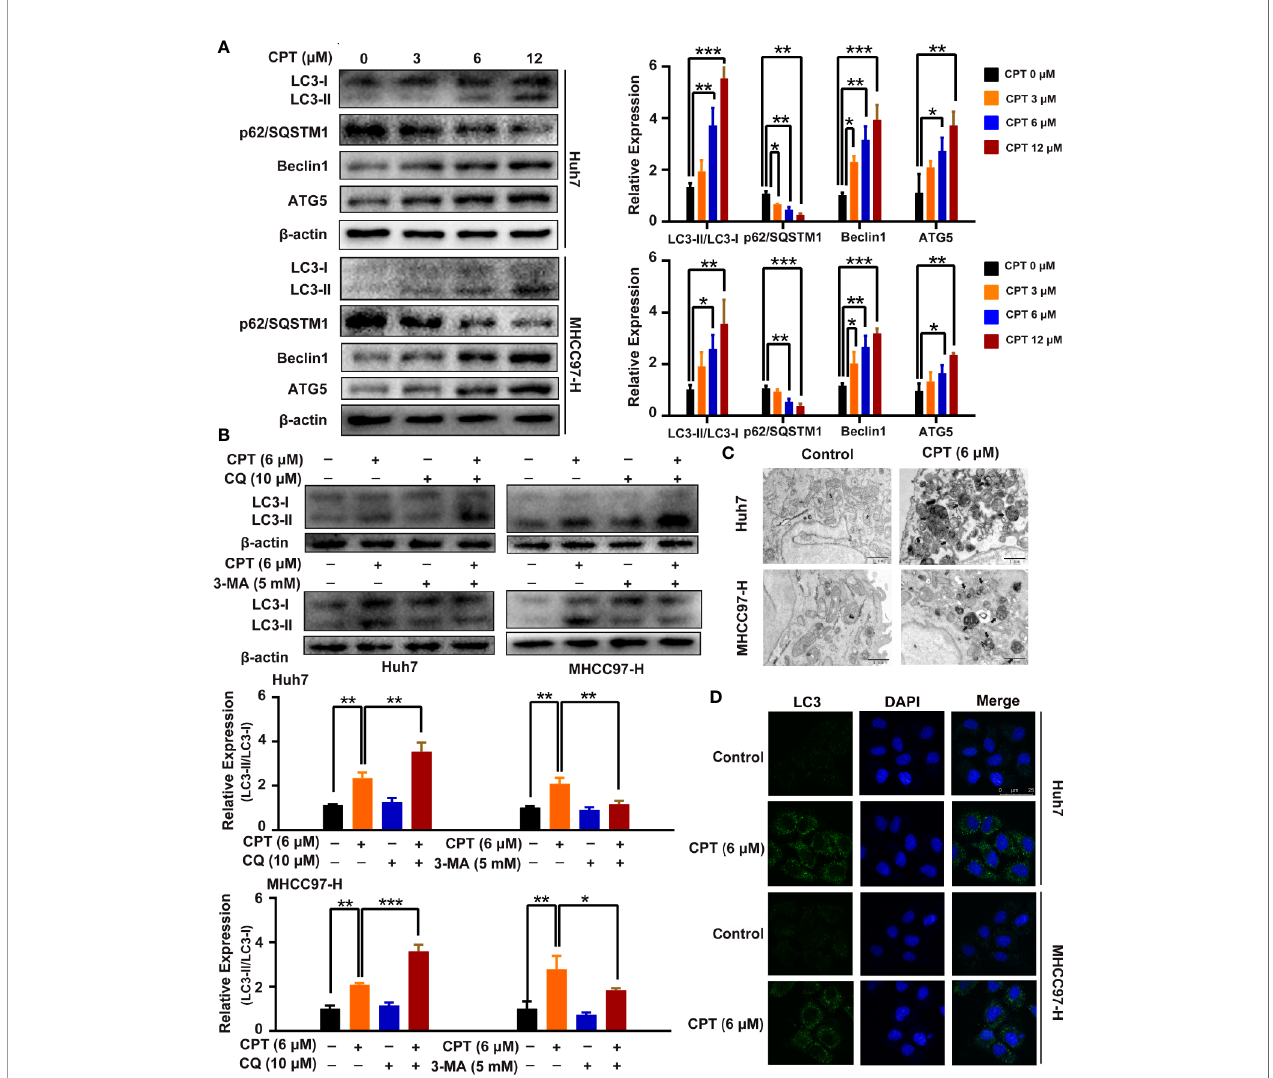
FIGURE 8 | Cryptotanshinone (CPT) stimulates autophagy in Huh7 and MHCC97-H cells. (A) Western blot analysis of LC3-I, LC3-II, p62/SQSTM1, Beclin1, and ATG5 in human hepatocellular carcinoma (HCC) cells treated with the indicated concentrations of CPT (0, 3, 6, and 12 m M) for 24 h. * P < 0.05, ** P < 0.01, and *** P < 0.001 versus the control group. (B) Western blot analysis of LC3-I conversion to LC3-II in Huh7 and MHCC97-H cells treated with 6 m M CPT in the absence or presence of 10 m M chloroquine (CQ) or 5 mM 3-methylamphetamine (3-MA) for 24 h was conducted. * P < 0.05, ** P < 0.01, and *** P < 0.001 versus the CPT group. (C) Huh7 and MHCC97-H cells were treated with or without 6 m M CPT for 24 h. LC3B puncta were then stained with anti-LC3B antibody by immuno fl uorescence and imaged with a confocal microscope. (D) Cells were treated with or without 6 m M CPT for 24 h and the changes in ultrastructure were detected by transmission electron microscopy. Arrows: autophagosomes/autolysosomes. Scale bar: 1